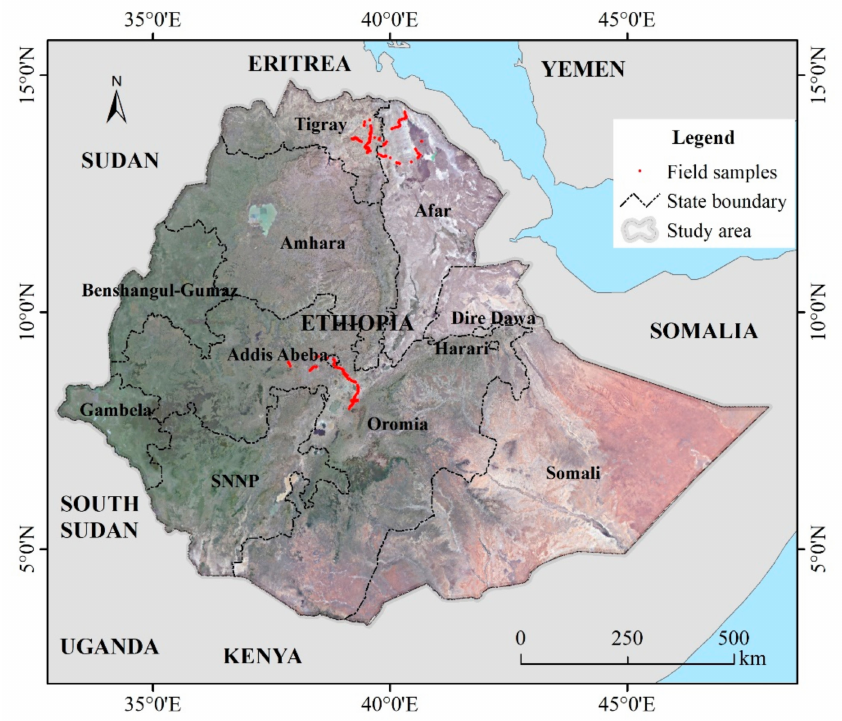
Figure 1. Ethiopia is in northeast Africa, and red points are the field samples obtained in